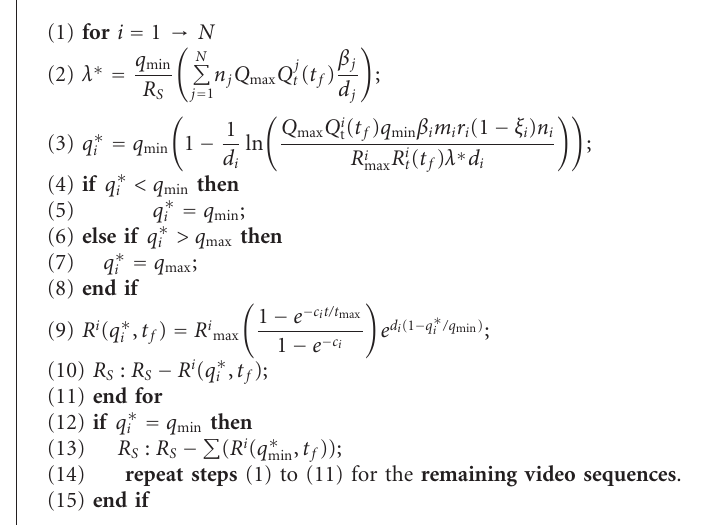
Algorithm 1: Optimal quality.